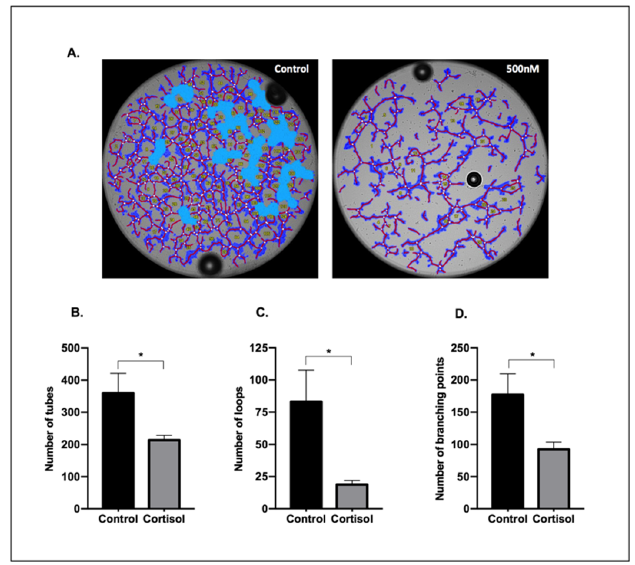
Figure A1. Tube-like structures formation—a pilot experiment. Representative images of tube formation ( A ) and the quantification of the number of tubes ( B ), loops ( C ), and branching points ( D ) of SGHPL-4 cells treated with vehicle (0 nM) or cortisol (500 nM) in the medium. Images were obtained after 5 h of stimulation. Data were compared with t-test and Shapiro–Wilk test; * p < 0.05. Data are presented as mean ± SEM. The quantification of tubes, loops, and branching points was done with the WimTube Software (Wimasis, Munich, Germany).